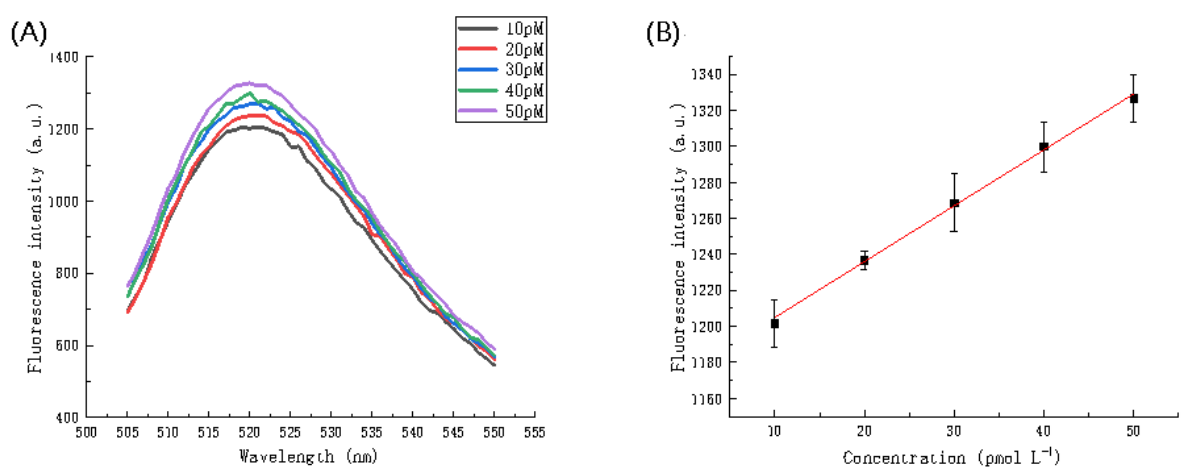
Figure 11. ( A ) Fluorescence spectra in the presence of different concentrations of miRNA (in buffer). ( B ) The relationship between fluorescence intensity in the buffer solution and the miRNA concentration. The error bars represent the standard deviation of three repeat experiments.